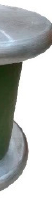
Figure 16. Experimental circuit 1-Industrial frequency power supply; 2-No partial discharge trans- former; 3-Protection resistor; 4-Dividing capacitor; 5-Coupling capacitor; 6-Detection impedance; 7–220 kV GIS.